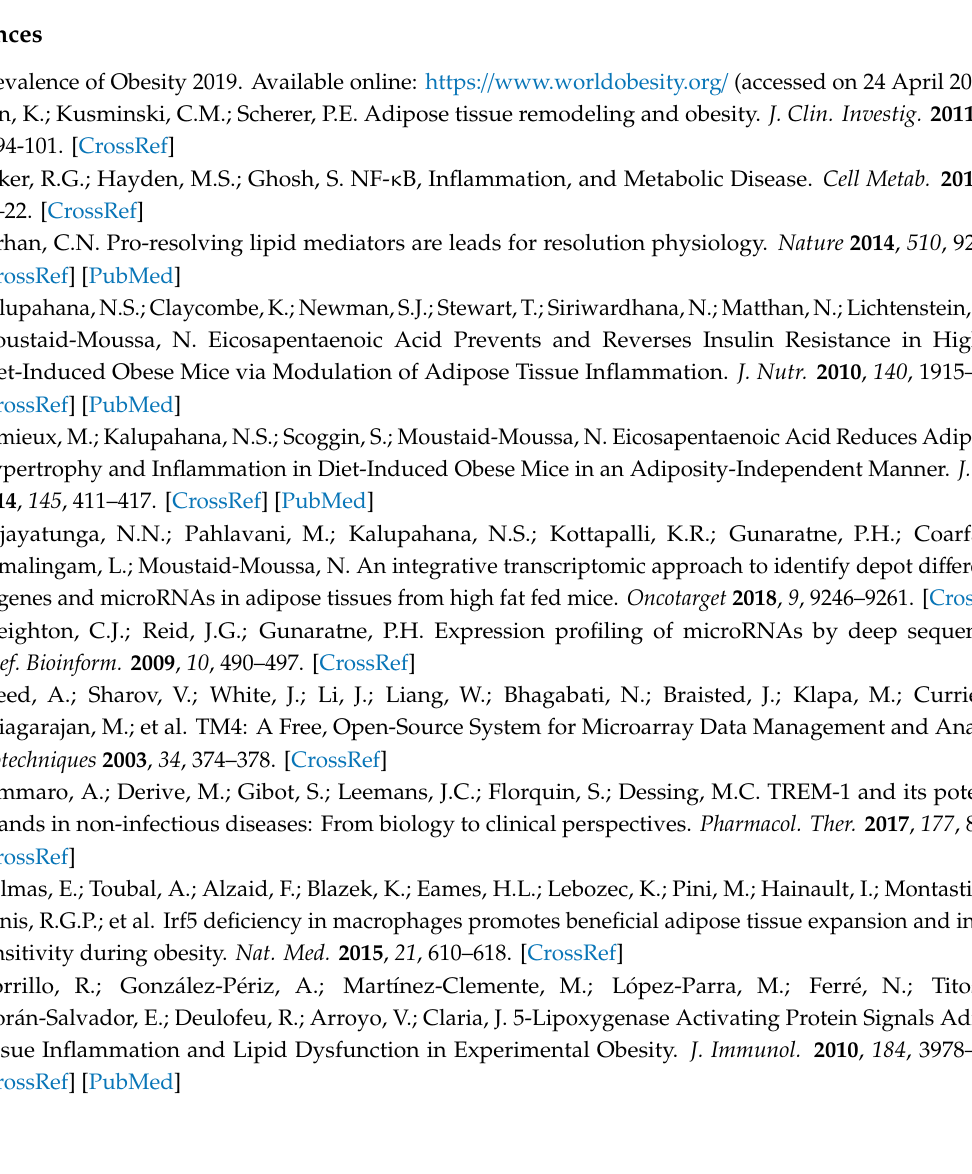
obese B6 mice, Table S4: Di ff erentially expressed microRNAs downregulated by EPA in visceral adipose tissue of obese B6